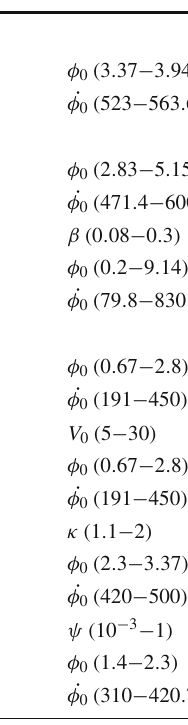
Table 2 The list of the dark energy phantom potentials and the free parameters